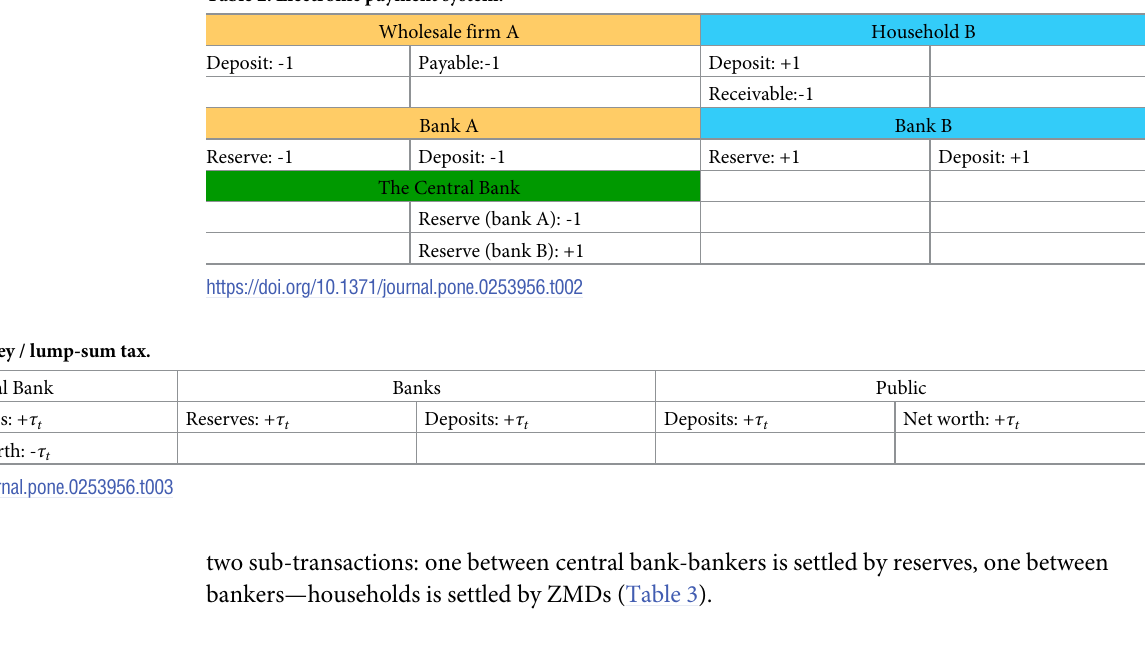
Table 2. Electronic payment